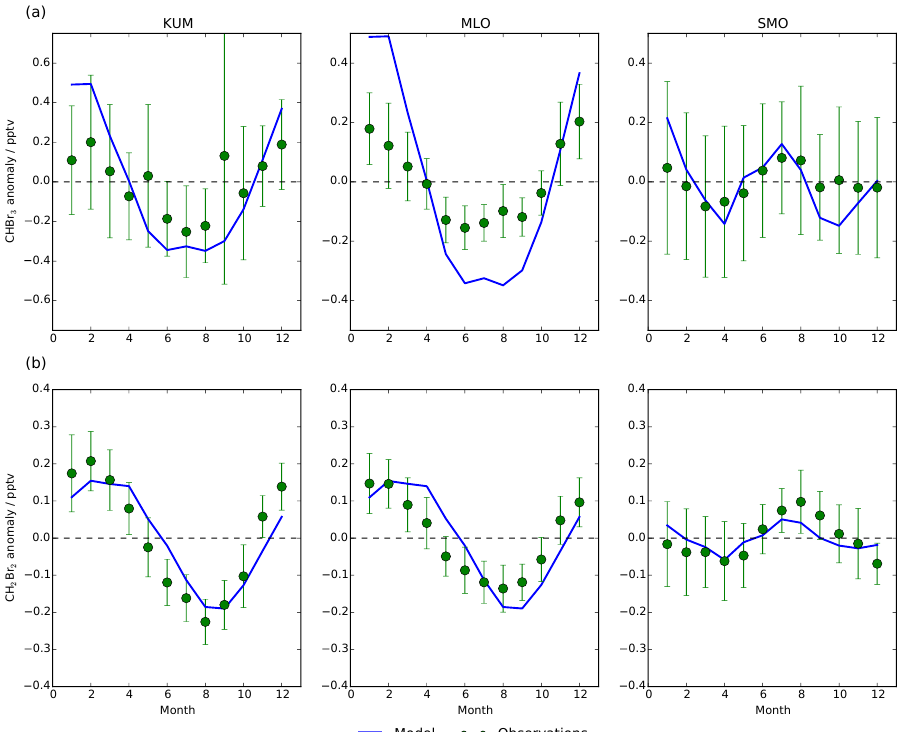
Figure A2. Observed (green) and model (blue) mole fractions of (a) CHBr 3 and (b) CH 2 Br 2 at tropical NOAA sites. The seasonal cycle is shown as the climatological monthly mean anomaly calculated by subtracting the annual mean from the climatological monthly mean (pptv). Horizontal bars on observed values denote ± 1 σ .